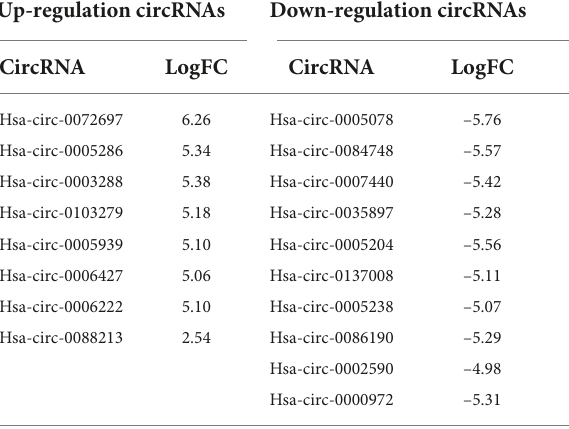
on. The top 10 markedly enriched BPs by GO